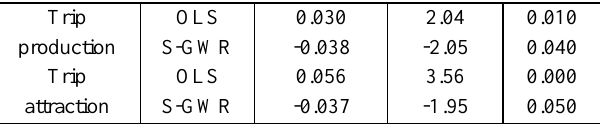
Table 8. Results of Moran's I for residuals of global OLS and MGWR